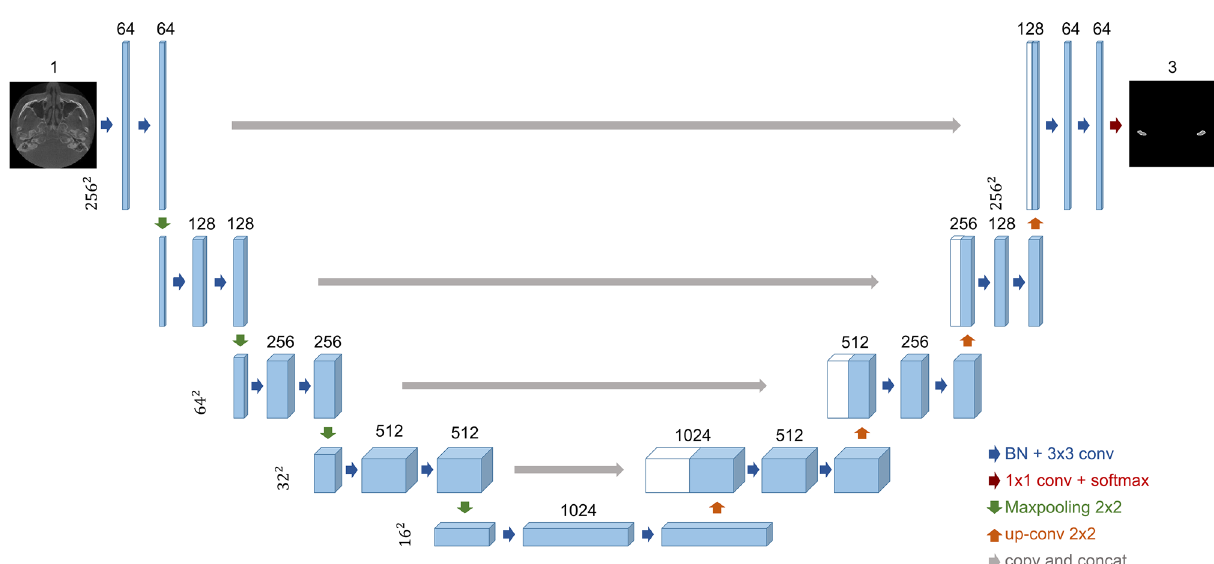
Figure 2. The proposed U-Net architecture used to segment the cortical and marrow parts of the condyle head. Unlike the original U-Net model, it uses batch normalization and concatenation without